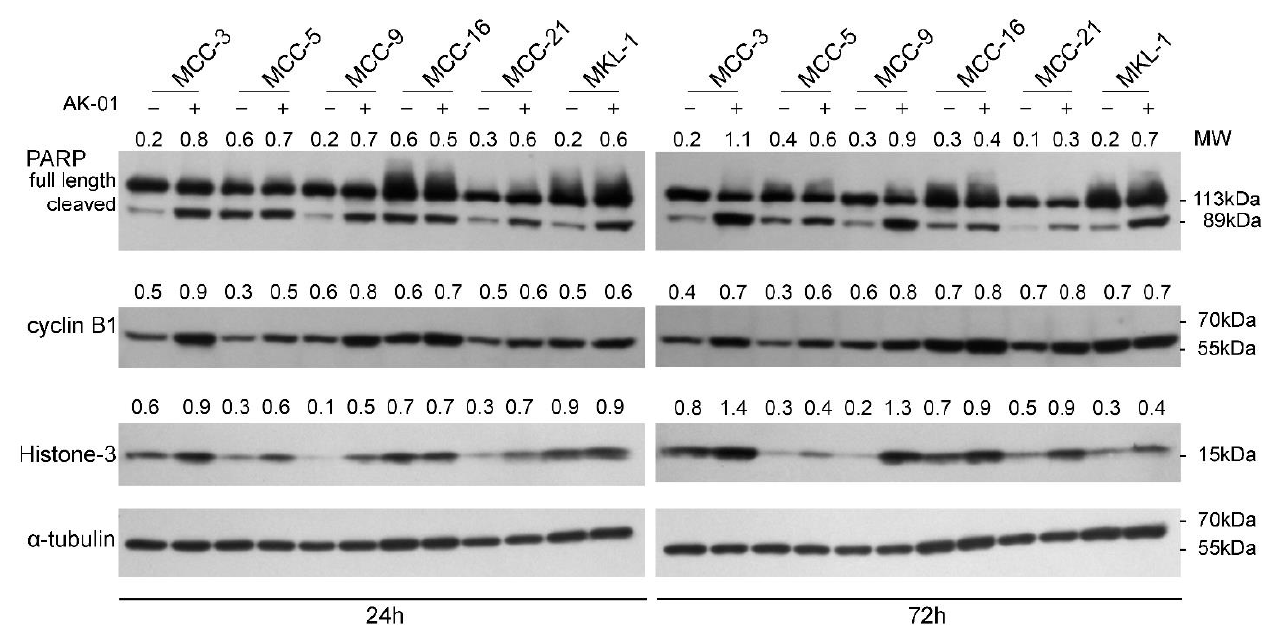
Figure 2. AURKA inhibition causes increased cleaved PARP and accumulation of cyclin-B and histone-3 in MCC cells. Vehicle (DMSO) or AK-01 (300 nM) treated MCC cells were harvested after 24 or 72 h, and 10–30 µ g of total cell lysate per lane were resolved in SDS-PAGE followed by immunoblotting using specific antibodies for PARP (total and cleaved), cyclin-B1, H3, and tubulin (loading control). All data represent contiguous lanes from one of three replicate experiments. Densitometry data (ratio of target protein compared to tubulin) was calculated using ImageJ and is presented above each lane of each respective immunoblot. Full western blot images are available in Figures S3 – S6. MW, molecular weight; kDa, kilodaltons.